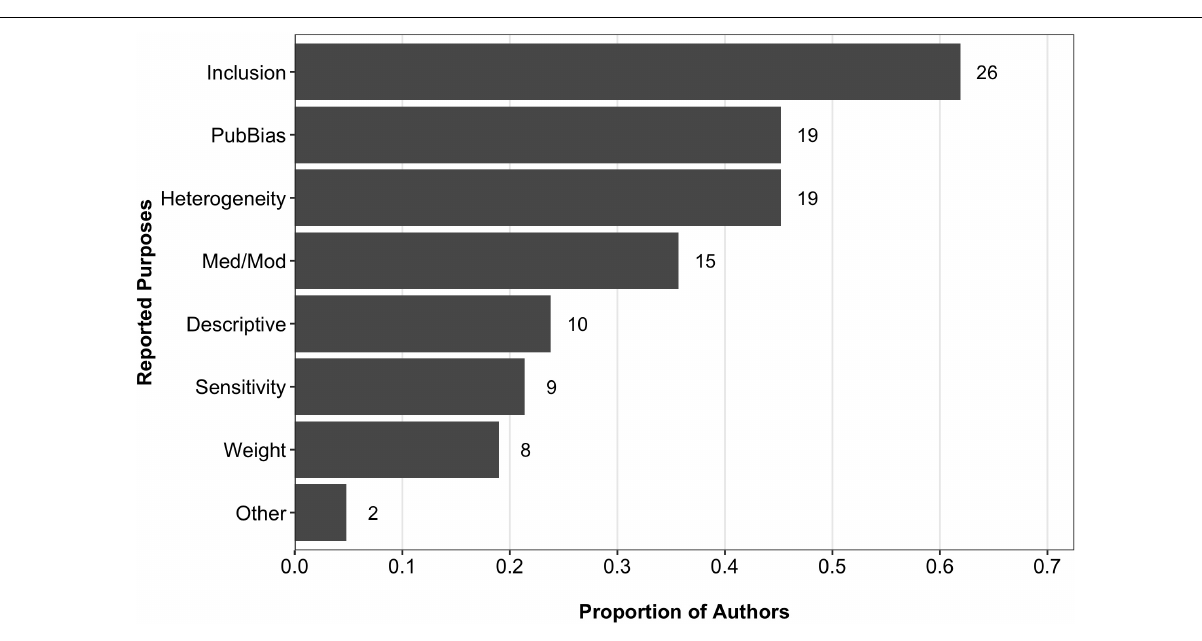
FIGURE 3 | Proportions and frequencies of purposes authors cite for assessing PSQ. Data source: survey of first authors. Descriptive, descriptive assessment only; Inclusion, inclusion criteria; Pred/Mod, use of quality as a predictor or moderator; PubBias, publication bias; Sen/Sub, sensitivity/subgroup analysis. N = 42. Because authors were able to indicate more than one purpose, proportions do not sum to